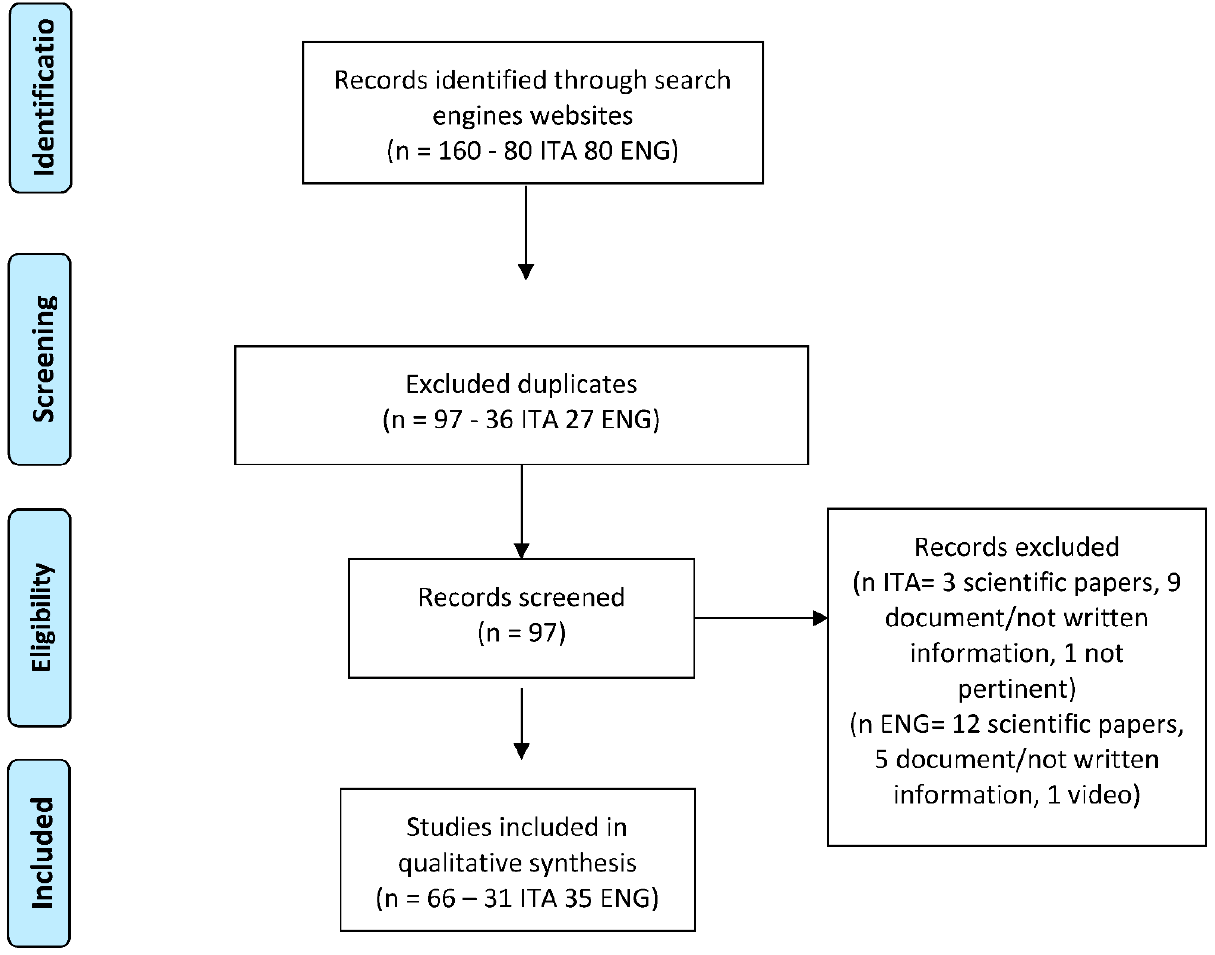
Figure 1. PRISMA Flow diagram of search results. For both languages, the most numerous sites were elected by the search engine Google (Ita. = 16, Eng. = 17), followed by Yahoo 19 (Ita. = 11, Eng. = 8); from the search engine DuckDuckGo only sites in English were elected—9, while Bing included websites from both languages 5 (Ita. = 4, Eng. = 1) (Table